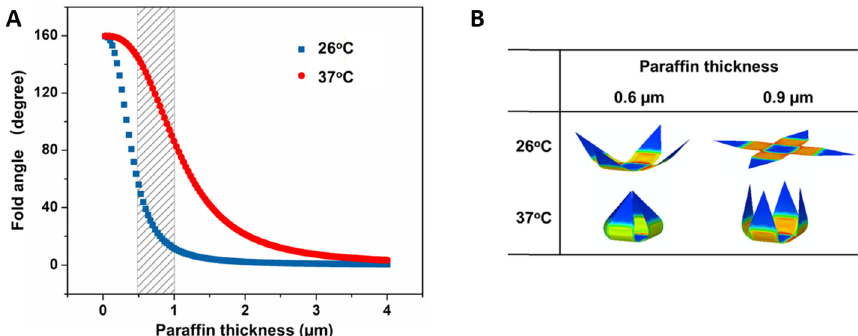
Figure 8. Effect of paraffin wax thickness on folding behavior. ( A ) As the thickness of the paraffin wax layer increases, the fold angle of the microgripper fingers decreases due to an increase in device rigidity. ( B ) Finite element modeling of microgrippers within the optimal thickness range shows the folding behavior of the devices at 26 and 37 °C. Reproduced with permission from Ref. [16]. Copyright 2020.